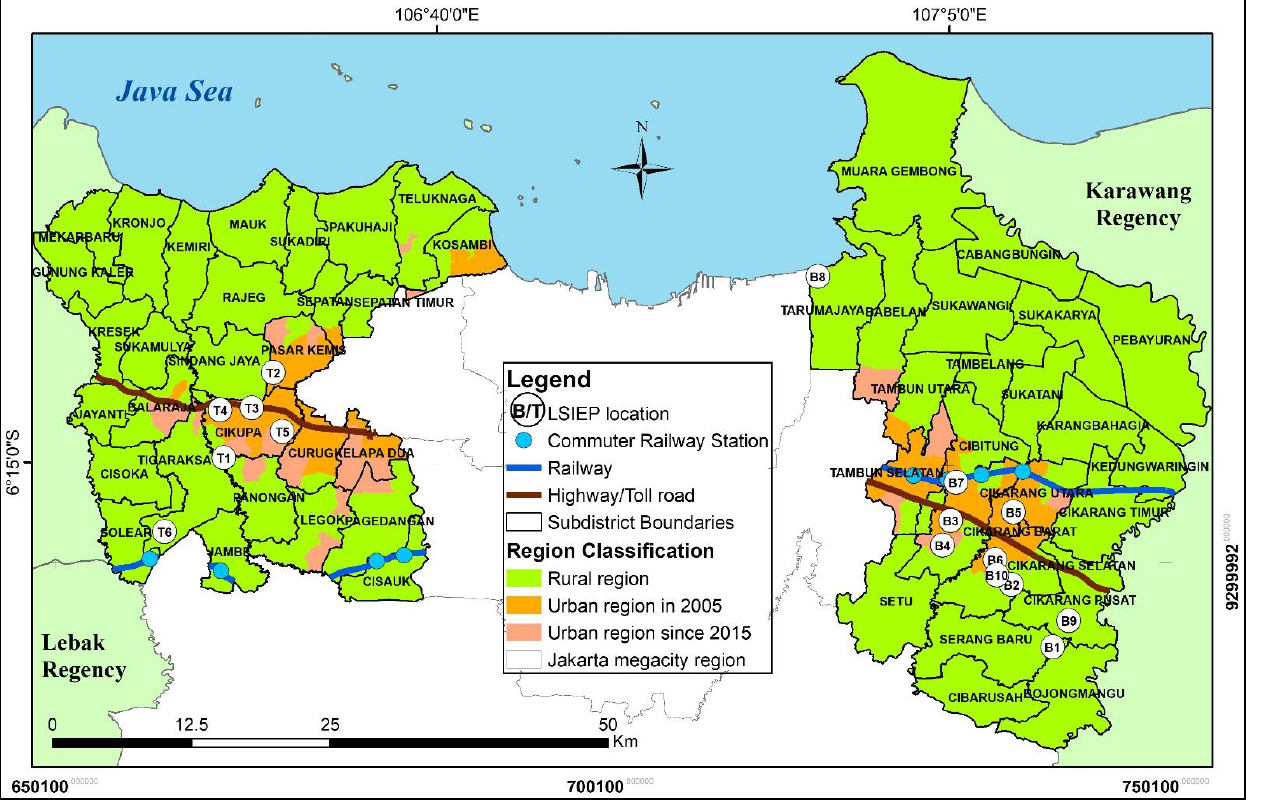
Figure 8. Regional typology (2005 – 2015) based on the RULT index.